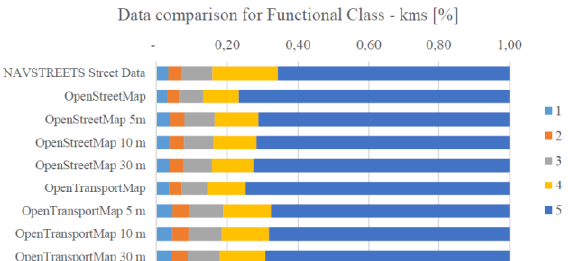
Figure 3: Data comparison for functional class, as percentage of total